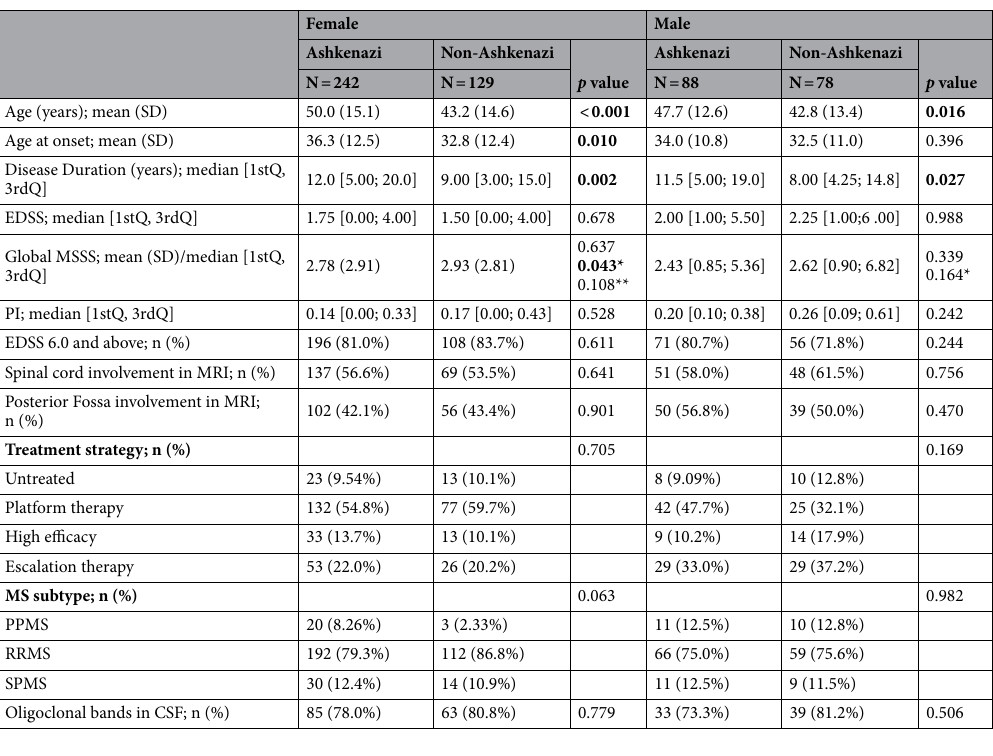
Table 4. Disease phenotype by sex. This table presents differences in disease phenotype between groups with stratification to sex. Variables that were normally distributed according to Shapiro test ( p value < 0.05) are presented in the format of mean (SD) and compared using Student T-test. The MSSS in females was compared using student T-test as accepted for continuous scales in large samples. Non-normal variables are presented by median [1st quartile, 3rd quartile], and compared using Mann-Whitney U test. Categorial variables are compared using Chi-squared test and presented with count (%). p values in bold denote statistical significance (p < 0.05). p values marked by one asterisk (*) are controlled for age at EDSS, while those marked with 2 asterisks (**) are controlled for age at onset using ANCOVA. EDSS Expended Disability Status Score, MSSS Multiple Sclerosis Severity Score, PI Progression Index, MRI magnetic resonance imaging, PPMS primary progressive multiple sclerosis, RRMS relapsing remitting multiple sclerosis, SPMS secondary progressive multiple sclerosis, CSF cerebrospinal